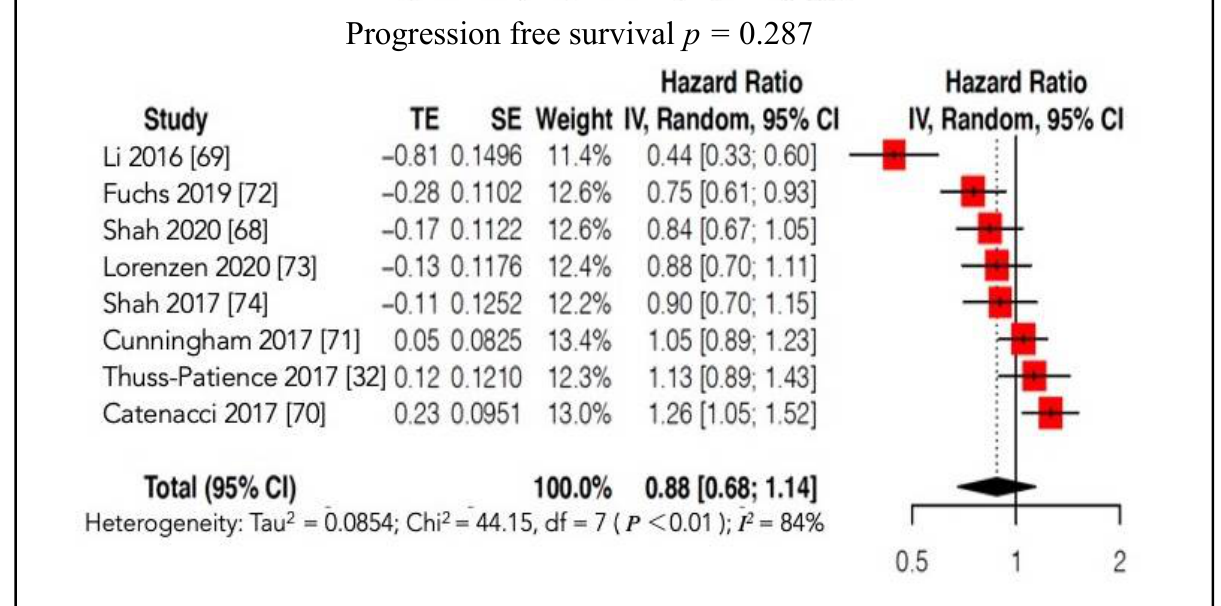
14 of 26 Figure 4. Forest plot of comparison: molecular-targeted therapy alone/plus chemotherapy versus chemotherapy alone/pla-